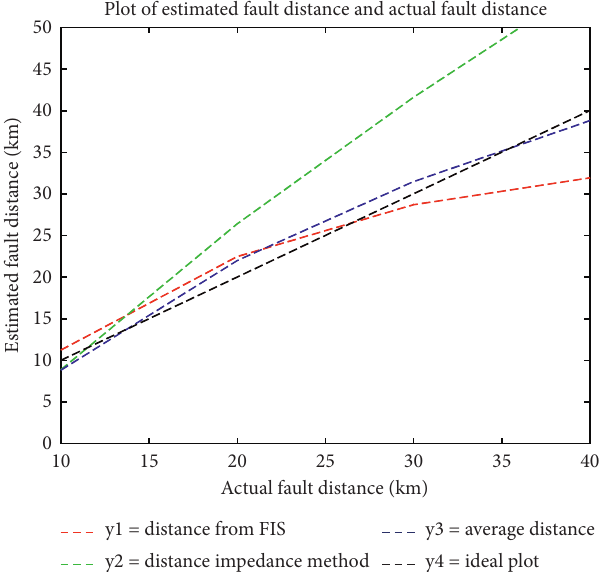
Plot of estimated fault distance and actual fault distance